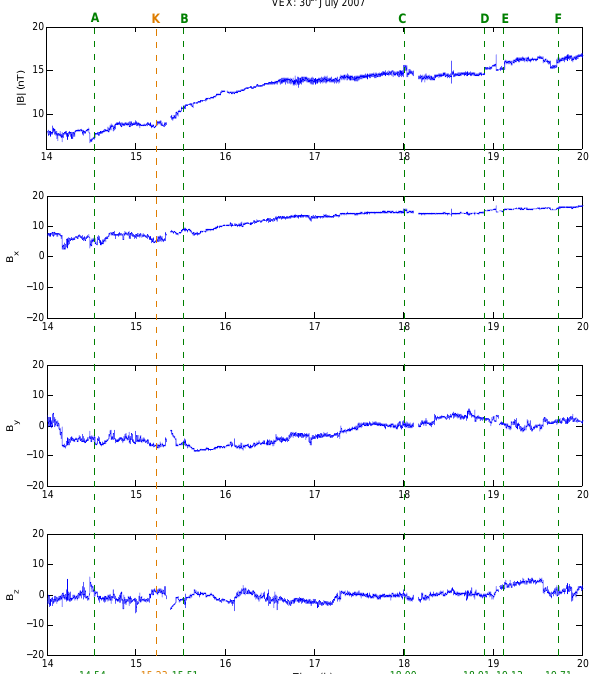
Fig. 6. Close-up view of the shocks presented in Fig. 4. Caption of Fig. 4